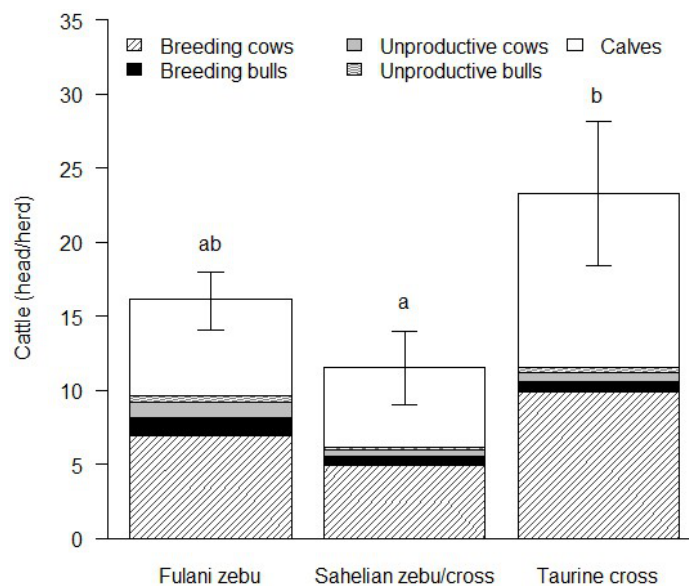
Figure 1. Composition and structure of cattle herds in Ouagadougou (mean ± standard error); Fulani zebu n = 42 herds, Sahelian zebu/cross n = 25 herds, taurine cross n = 13 herds. Means with different superscript letters are significantly different (Tukey multiple comparison of means; p < 0.05).